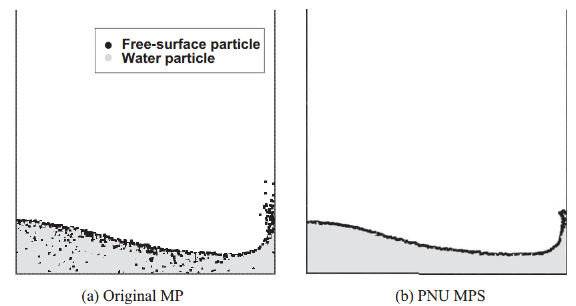
Fig. 1: Identification of free-surface particles